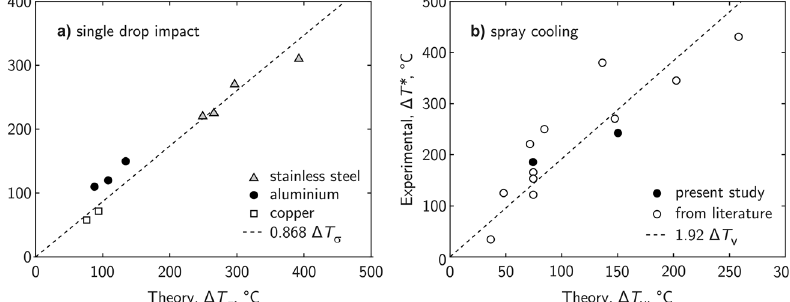
experimental threshold overheat Δ T * ≡ T * − T sat is de fi ned as threshold temperature T * from which on the residence time t r is constant and single drops